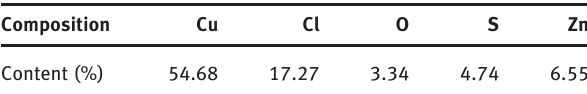
Table 1: Chemical composition of the CuCl residue from a zinc hydrometallurgy process.